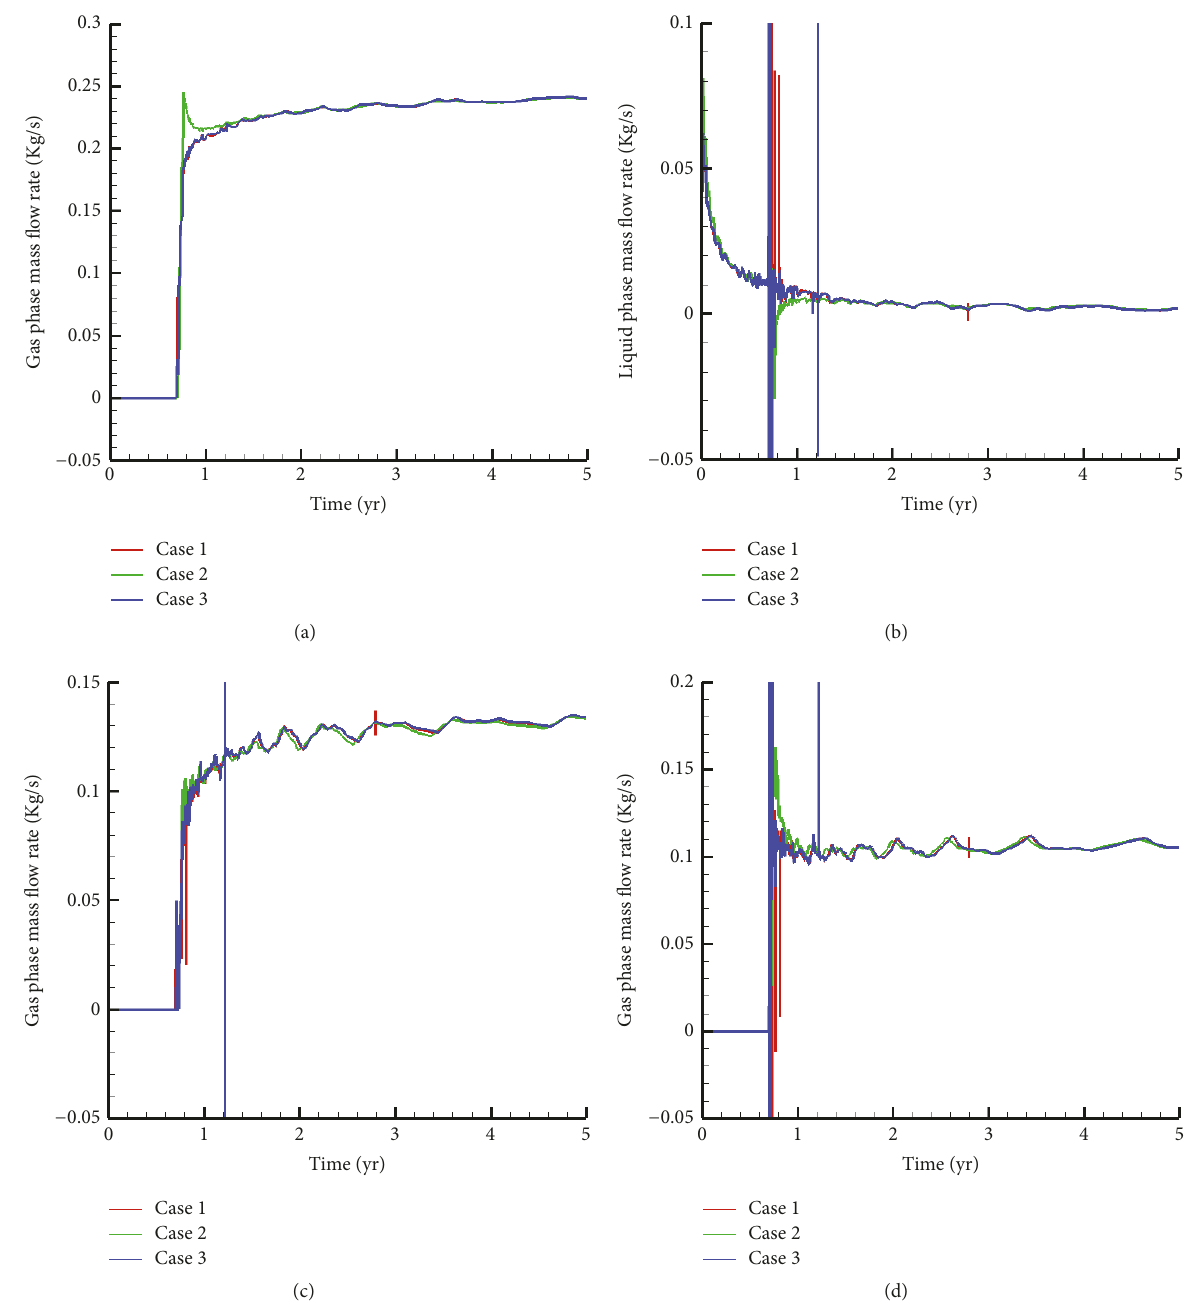
Figure 17: Fluids dynamics at the outlet/inlet of each aquifer in Cases 1–3 for whole time scale of CO 2 injection.